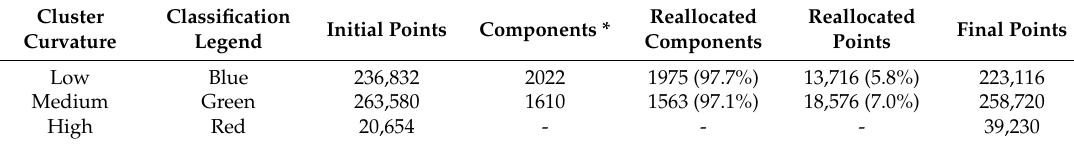
Figure 10. Initial MLS set of clusters: (i) planar or low curvature in blue; (ii) cylindrical, mild transitions and medium curvature in green; and (iii) the abrupt transitions of high curvature in red. Table 6. Results of clustering refinement step (* the components are the result of the curvature clustering phase according to the main geometric elements of the CH site).